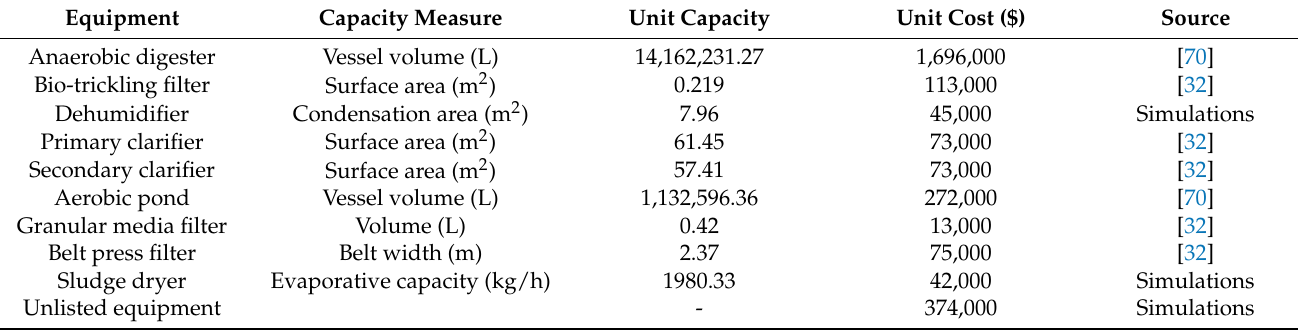
Table A5. Equipment purchase